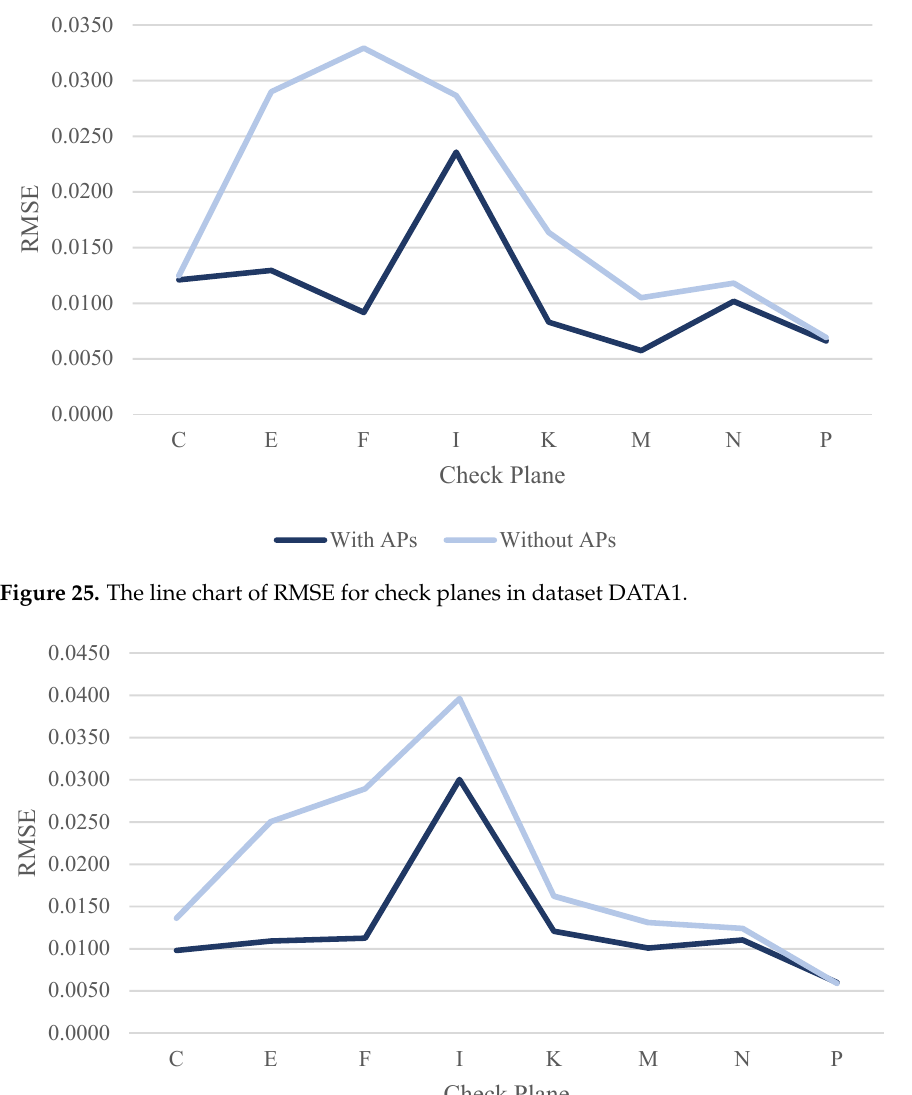
For the dataset DATA3, the RMSE of check plane C was not improved. However, the difference was only 0.0003 m. The RMSEs of the remaining 7 planes were improved after correcting the ranging system error (see the RMSE line chart of each check plane in Figure 27). With up to 54.77% in plane E, an increase of about 1.4 cm and an improvement of 0.8 cm in plane F were reached. The overall average improvement was 14.70%. The improvement of dataset DATA3 was less than that of the dataset DATA2. Meanwhile, the quality of the point cloud in dataset DATA3 was better than that of the dataset DATA2 because the mean RMSE without APs of dataset DATA3 (0.0160 m) was less than the mean RMSE without APs of dataset DATA2 (0.0194 m). The RMSE in plane I was still larger than about 2 cm among the three datasets (see Tables 11–13 and Figures 25–27) after the ranging